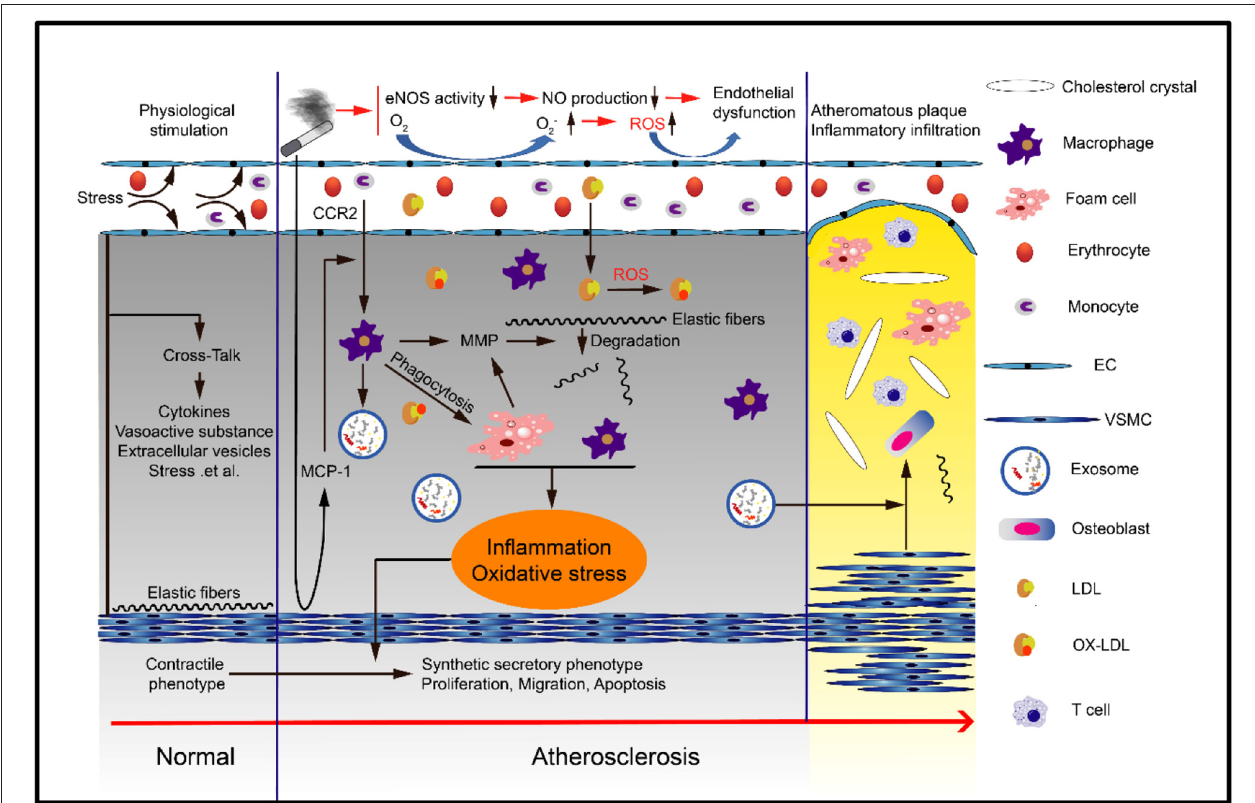
FIGURE 2 | Smoking can cause atherosclerosis. Smoking can cause endothelial cell dysfunction, monocyte differentiation into macrophages and eventually foam cells, smooth muscle cell proliferation, migration and phenotypic transformation, and extracellular matrix degradation and remodeling. These processes are typically mediated by oxidative stress and